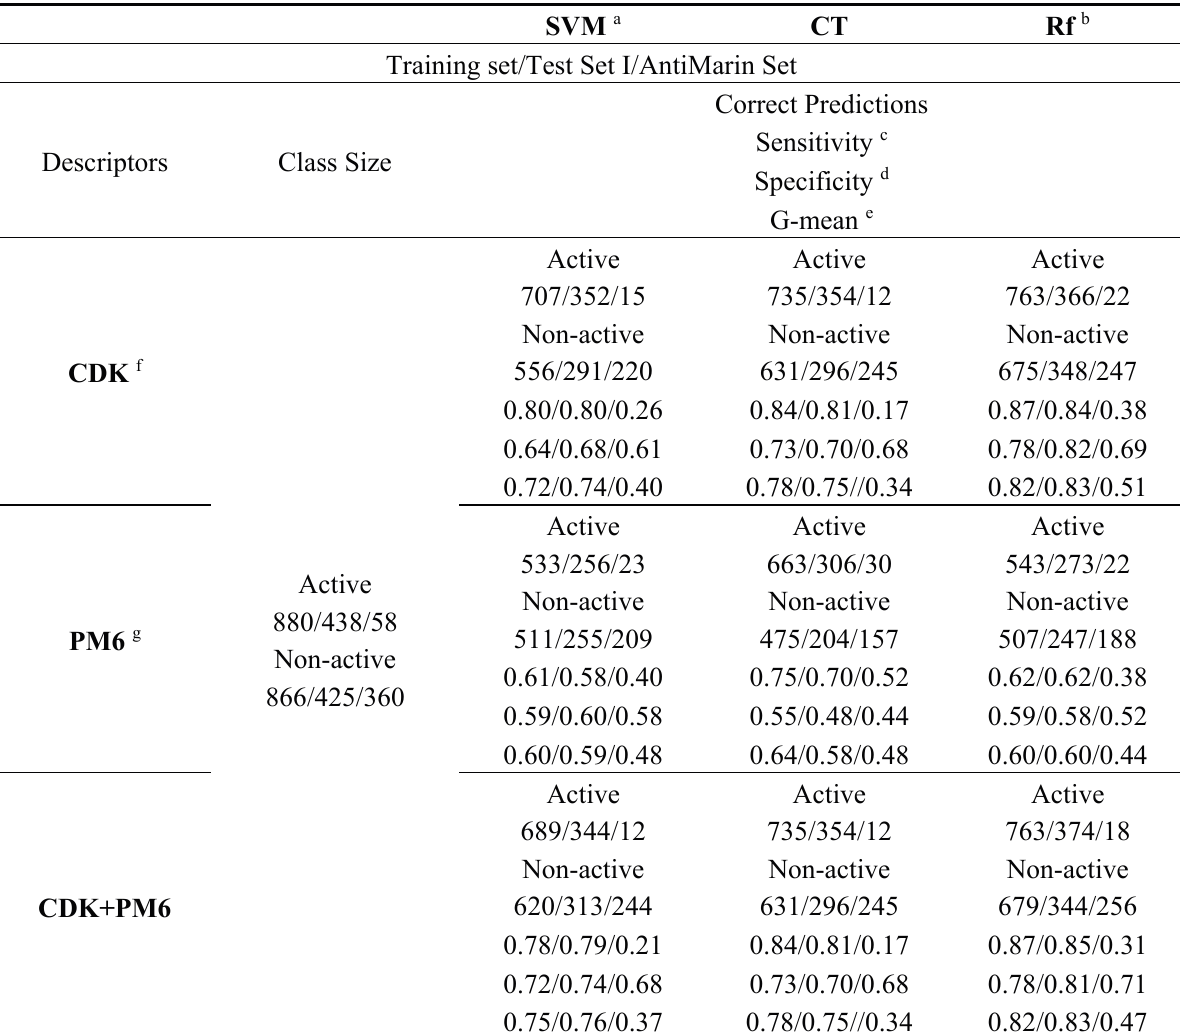
Table 2. Comparison of different ML techniques and descriptors for building antitumor activity classification